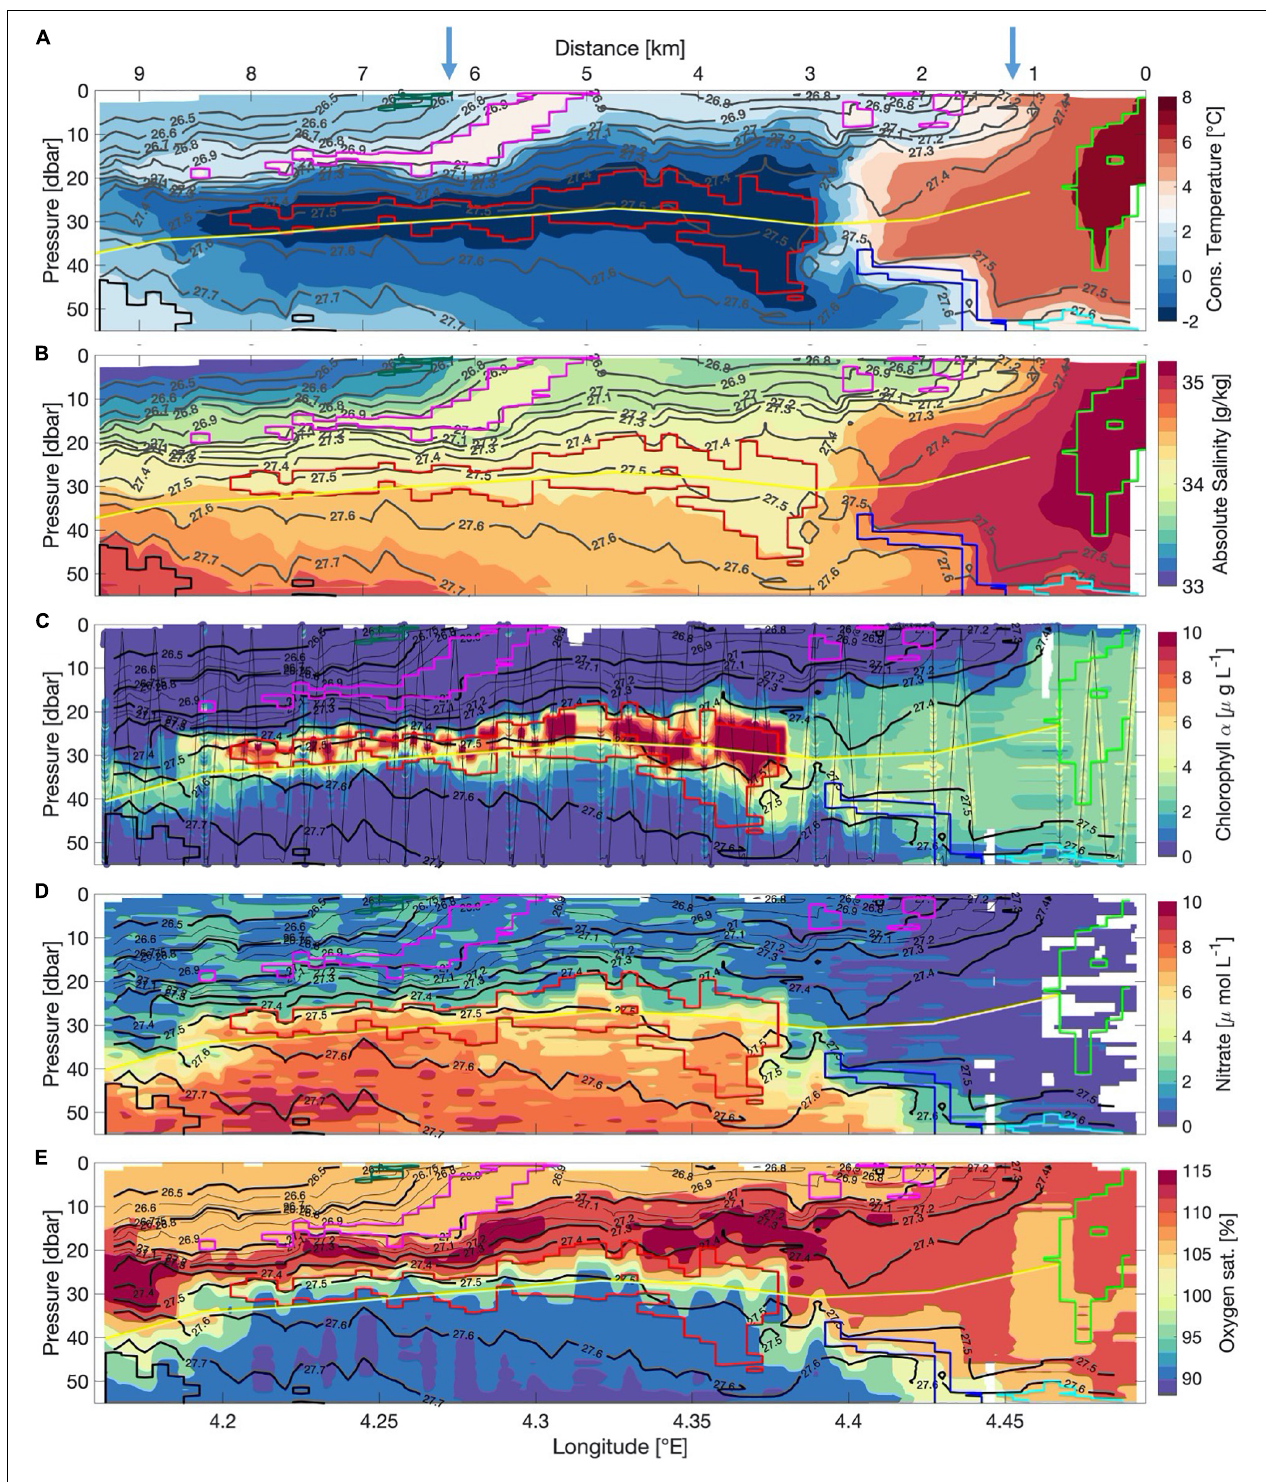
FIGURE 2 | (A) Conservative temperature ( ◦ C), (B) absolute salinity (g/kg), (C) chlorophyll a ( µ g L − 1 ), (D) nitrate ( µ mol L − 1 ) and (E) oxygen saturation (%). Black contour lines indicate potential density. Individual AUV-profiles are marked in black with a scatter plot showing the single-point measurements in panel (C) . Yellow line indicates the euphotic depth. Blue arrows at the top of panel (A) indicate the position of the two fronts. Colored contour line-boxes indicate different water masses [green – Atlantic Water, red – Polar Water, yellow, green and magenta – different types of surface waters, black and cyan – different types of colder and slightly fresher Atlantic Water, blue – mixed water originating from cabbeling (compare Temperature-salinity-diagram in Figure 3 )].